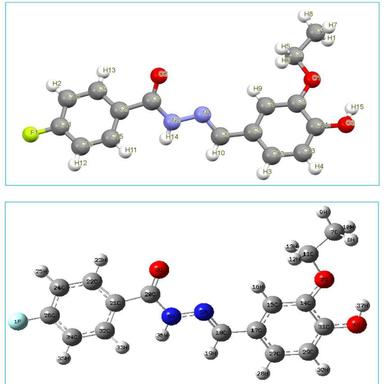
Experimental (top) and theoretical (bottom) structures of (E)-N- -(3-ethoxy-4-hydroxybenzylidene)−4-fluorobenzohydrazide.